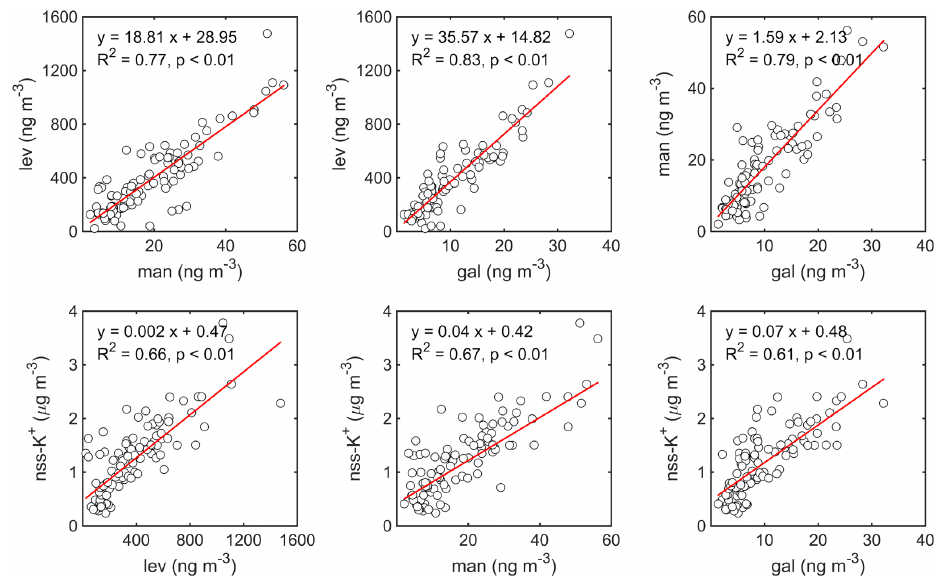
Figure 3. Correlations between four tracers of biomass burning including levoglucosan (lev), mannosan (man), galactosan (gal) and non- sea-salt potassium (nss-K + ) in PM 2 . 5 from 14 to 29 January 2015 in